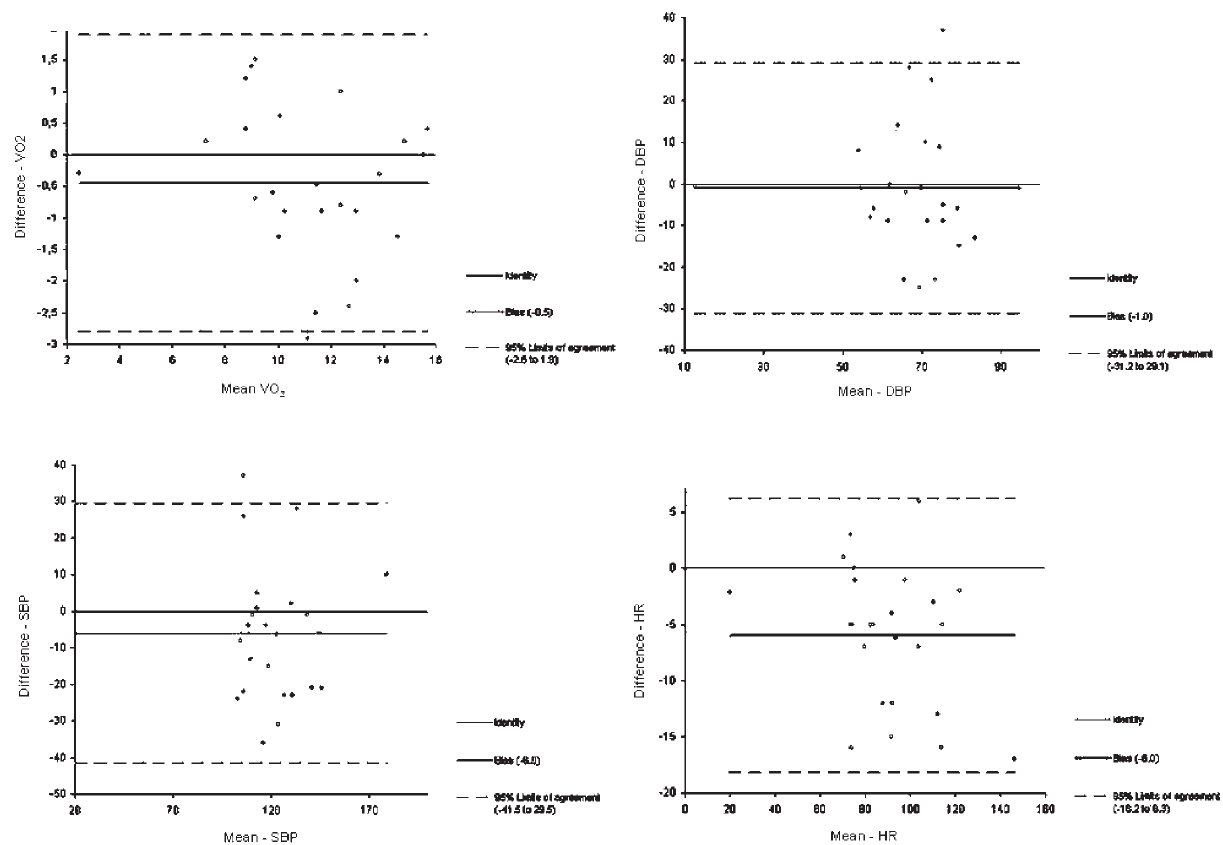
Figure 2 - Bland & Altman plots between test-1 and test-2 for VO2, Heart Rate (HR), Systolic (SBP) and Diastolic Blood Pressure